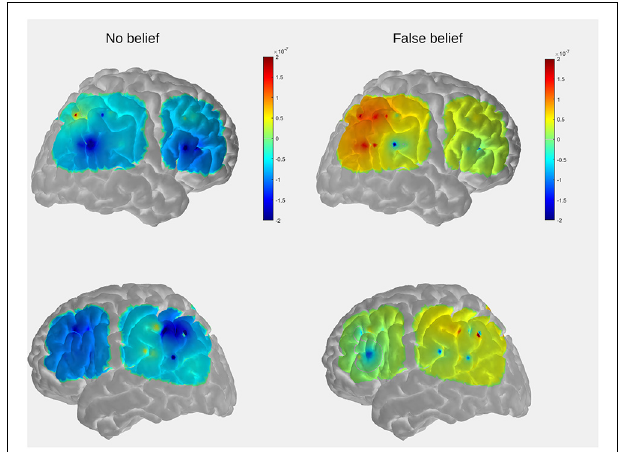
FIGURE 5 | The comparison of mean group results for the location-change period between conditions within the temporal, parietal, and prefrontal regions. The peak activation is observed in the posterior part of the right lateral